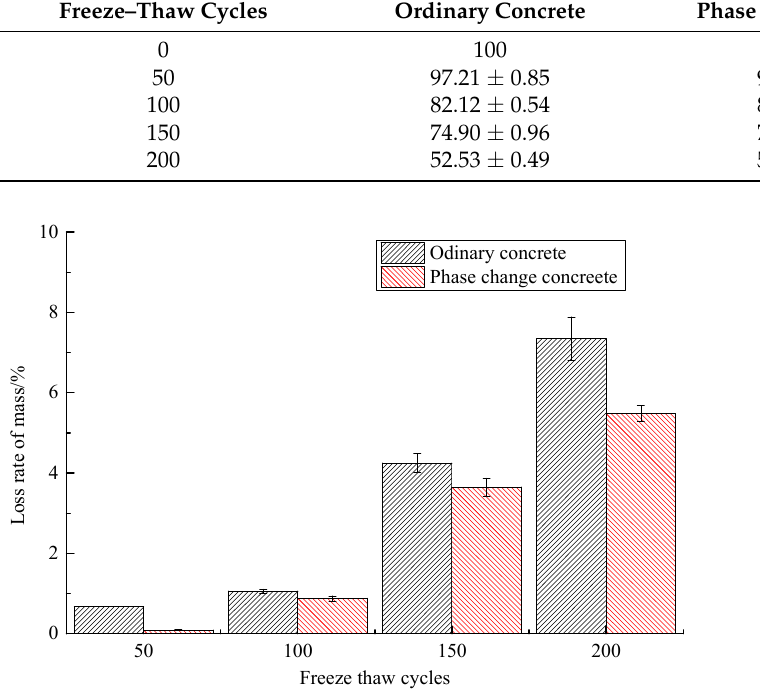
Figure 7. Change of mass loss rate of concrete during freeze–thaw cycles.